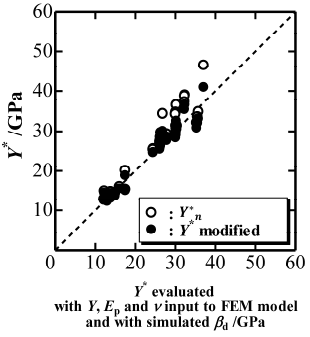
Figure 7. Representative indentation yield stress Y * estimated with simulated P - h curves plotted against Y * evaluated with mechanical properties inputted into the FEM model.